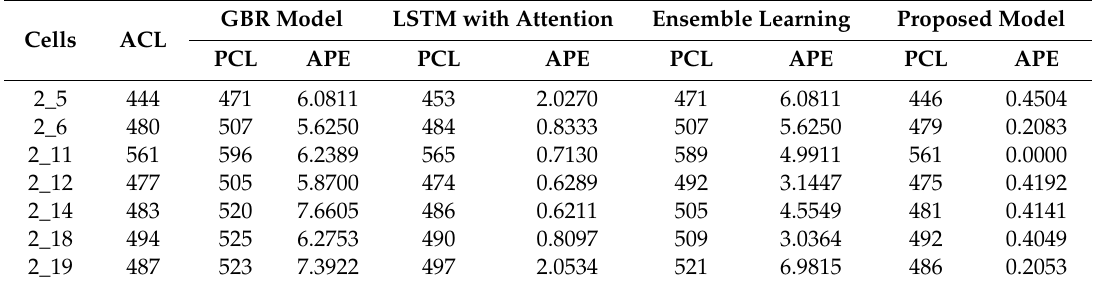
Table 6. The cycle life prediction results of di ff erent models using 70% of the total data as training data. Cells